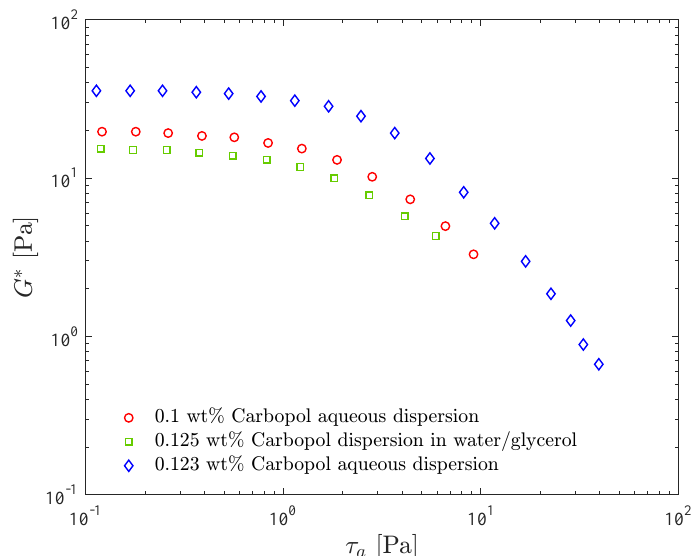
Figure 3. Stress amplitude sweep test resuts for three Carbopol dispersions: effects of the concentration and of the